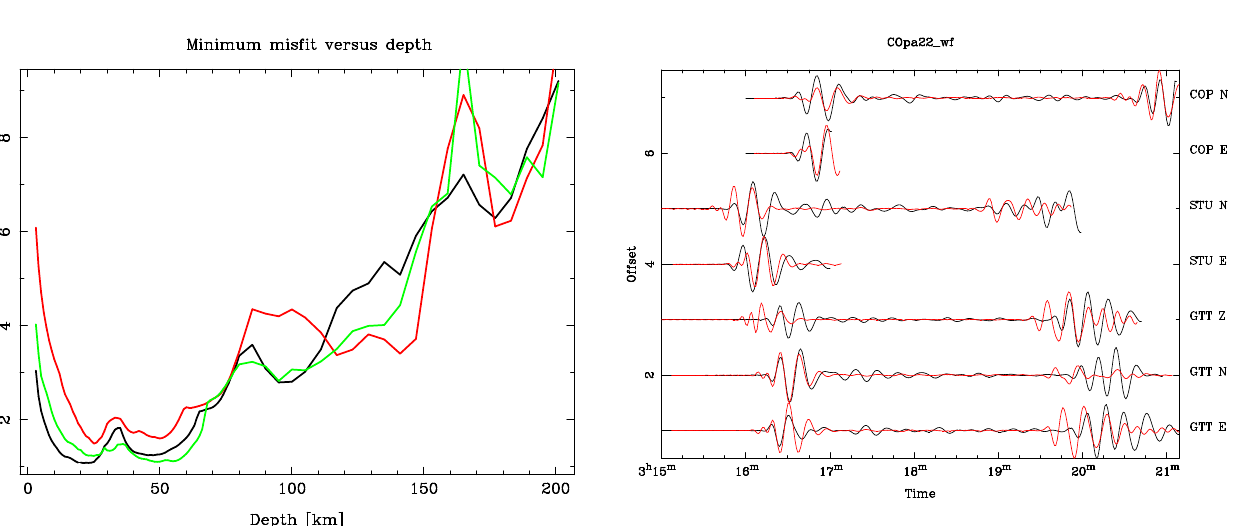
Figure 11. Example of a waveform fit for the Comninakis and Papazachos (1986) location and a source depth of 25km. Black traces are data and red traces are synthetics. Amplitude ratio of data and synthetics is correctly